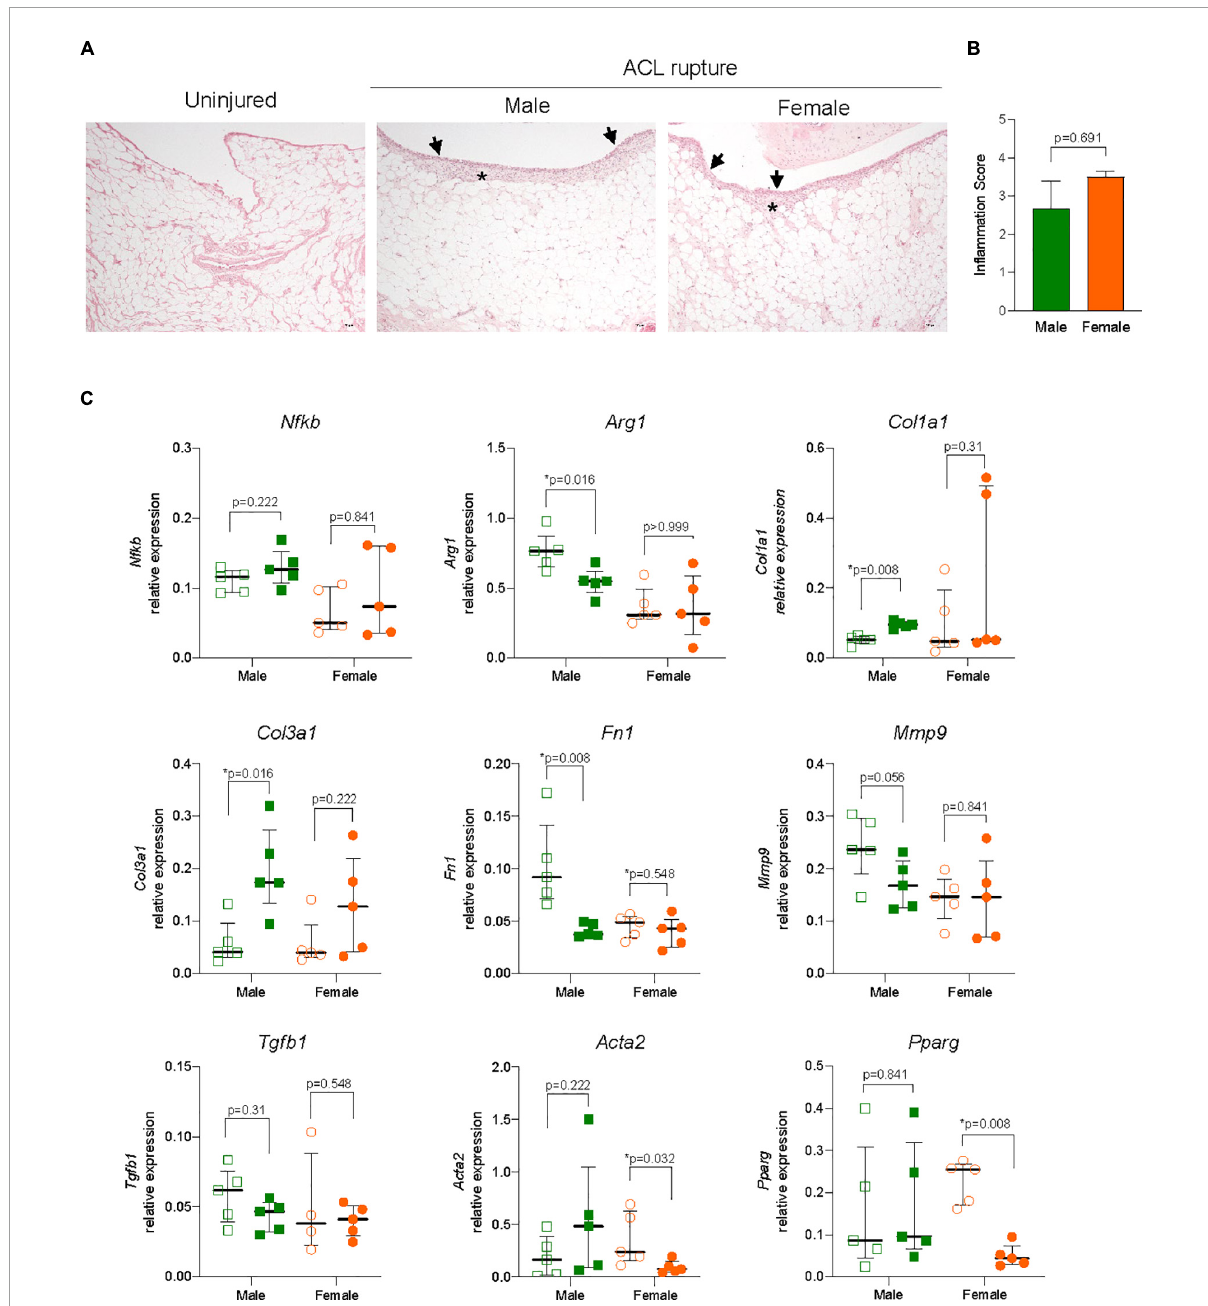
FIGURE5 Inflammation and extracellular matrix (ECM) remodeling in the infrapatellar fat pad (IFP). (A) Representative hematoxylin and eosin (H&E) stained sections, and (B) inflammation score of the IFP showing inflammatory cell infiltration to the synovial lining (arrowheads) and sub-synovial tissue (asterisk) (magnification, 100 × ) from male and female animals. (C) Relative expression of markers of inflammation (nuclear factor kappa B, Nfkb; arginase 1, Arg1); ECM components (collagen type 1, Col1a1; collagen type 3, Col3a1; fibronectin, Fn1); ECM remodeling enzymes (matrix metalloproteinase 9, Mmp9); and myofibroblast differentiation (transforming growth factor beta 1, Tgfb1; alpha smooth muscle actin, Acta2; peroxisome proliferator activated receptor gamma, Pparg) within the IFP of ACL-ruptured and control knees of male and female animals. Data show median ± IQR. Mann-Whitney U -test, * p <